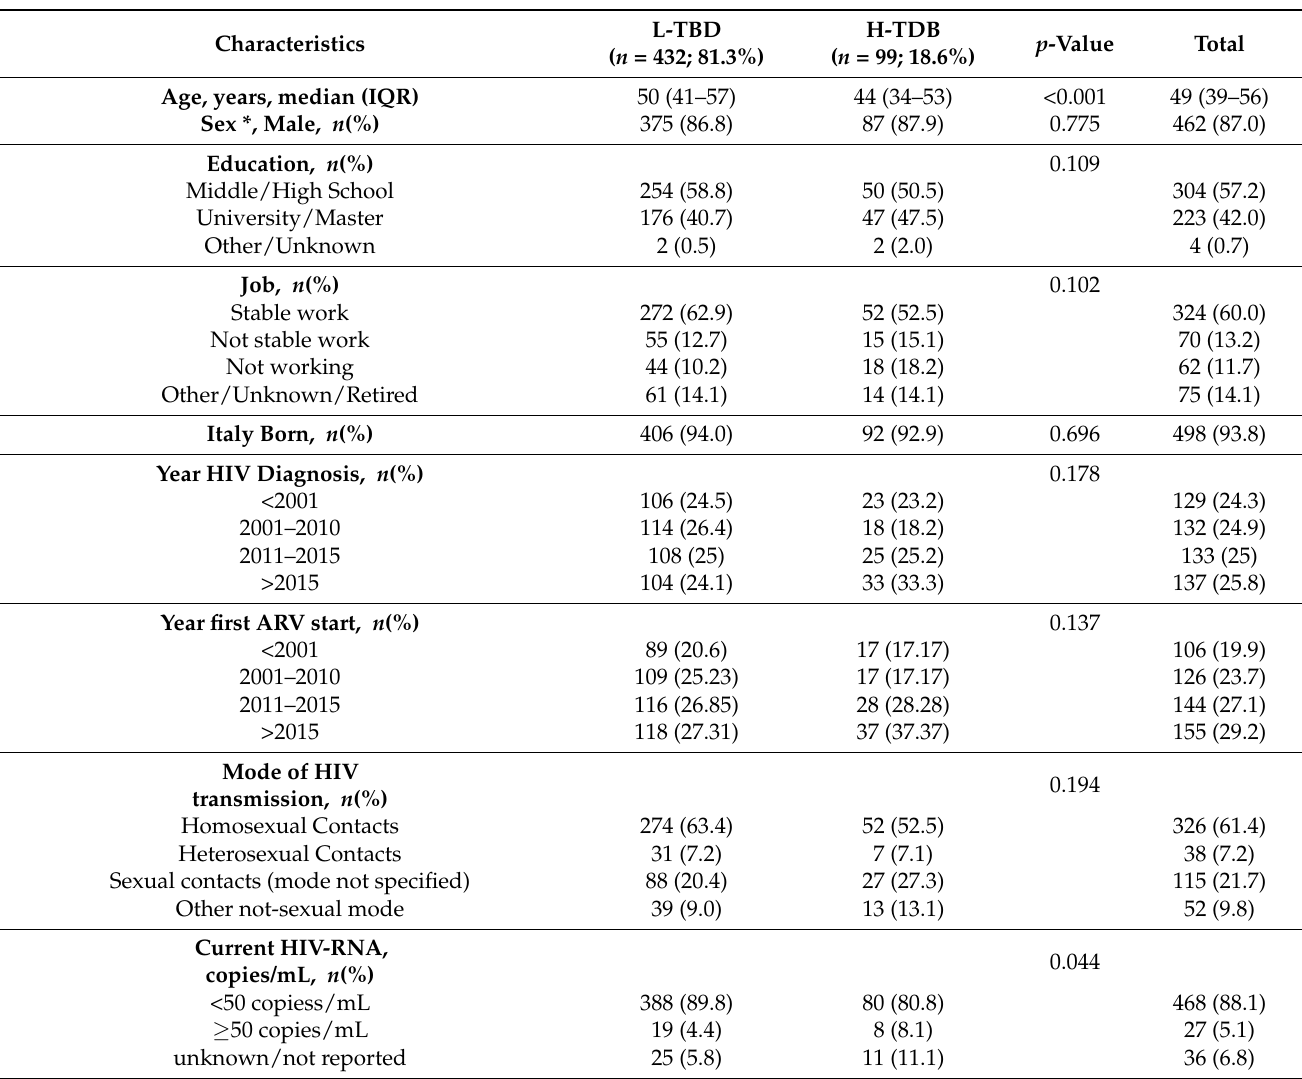
Table 1. Sociodemographic and clinical characteristics of PLHIV according with level of disease and treatment